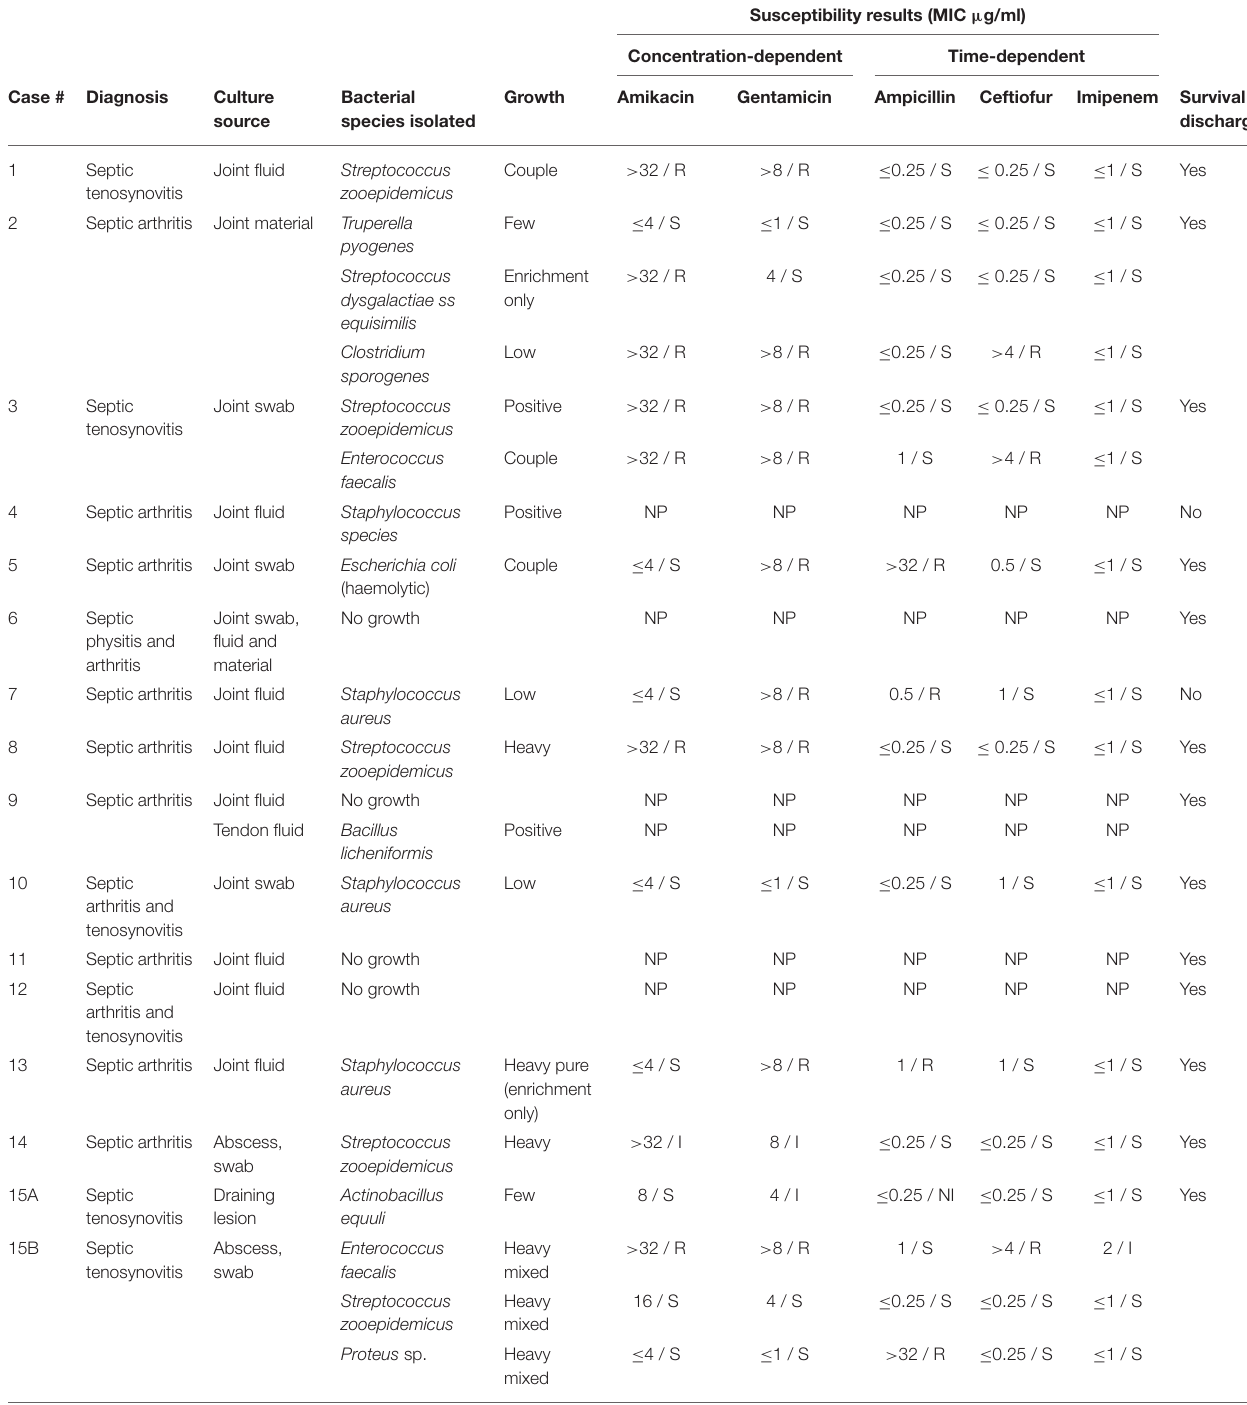
TABLE 4 | Bacterial culture and susceptibility results of horses treated with Meropenem via intravenous regional limb perfusion with growth characteristics as reported by the